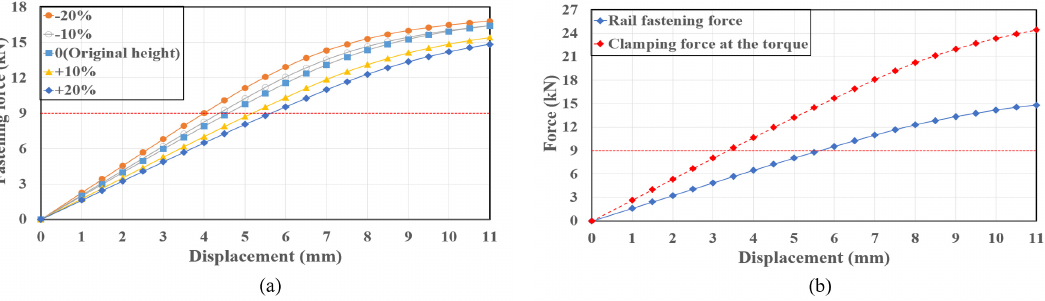
Figure 12. Force vs. displacement diagram: ( a ) fastening force vs. displacement when varying the spring width; ( b ) comparison of the clamping force at the torque with the rail fastening force for the +20% model.